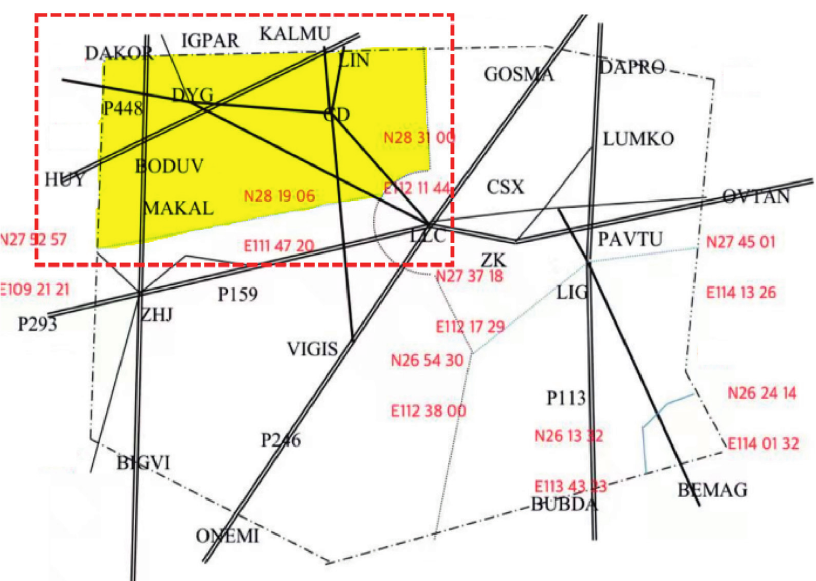
Figure 5: Target airspace sectors